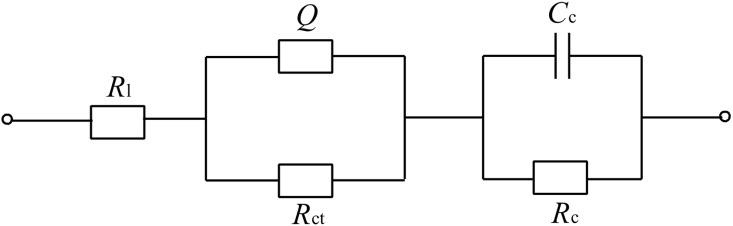
EIS equivalent circuit of CuS-GeO2-TiO2 composite coating electrode.